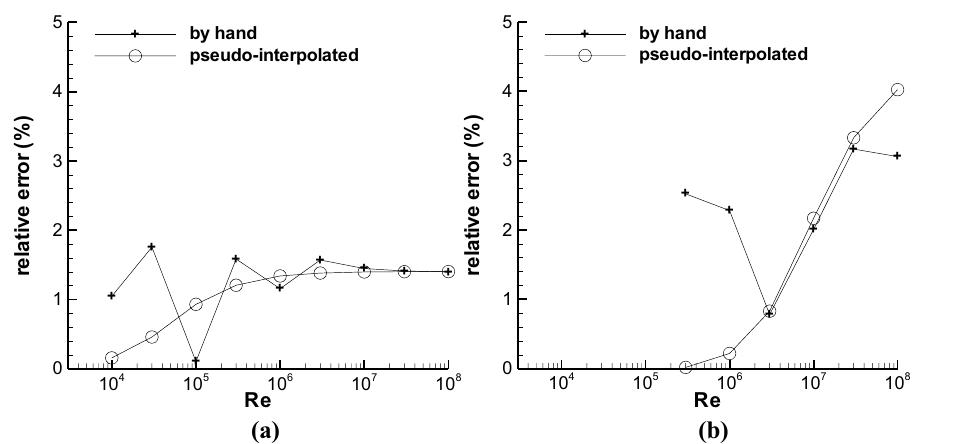
Figure 4. The relative errors obtained by both pseudo interpolation and manual methods, ( a ) at the pseudo- midpoint ε/d = 0.00283, ( b ) at ε/d = 2.24 × 10 −5